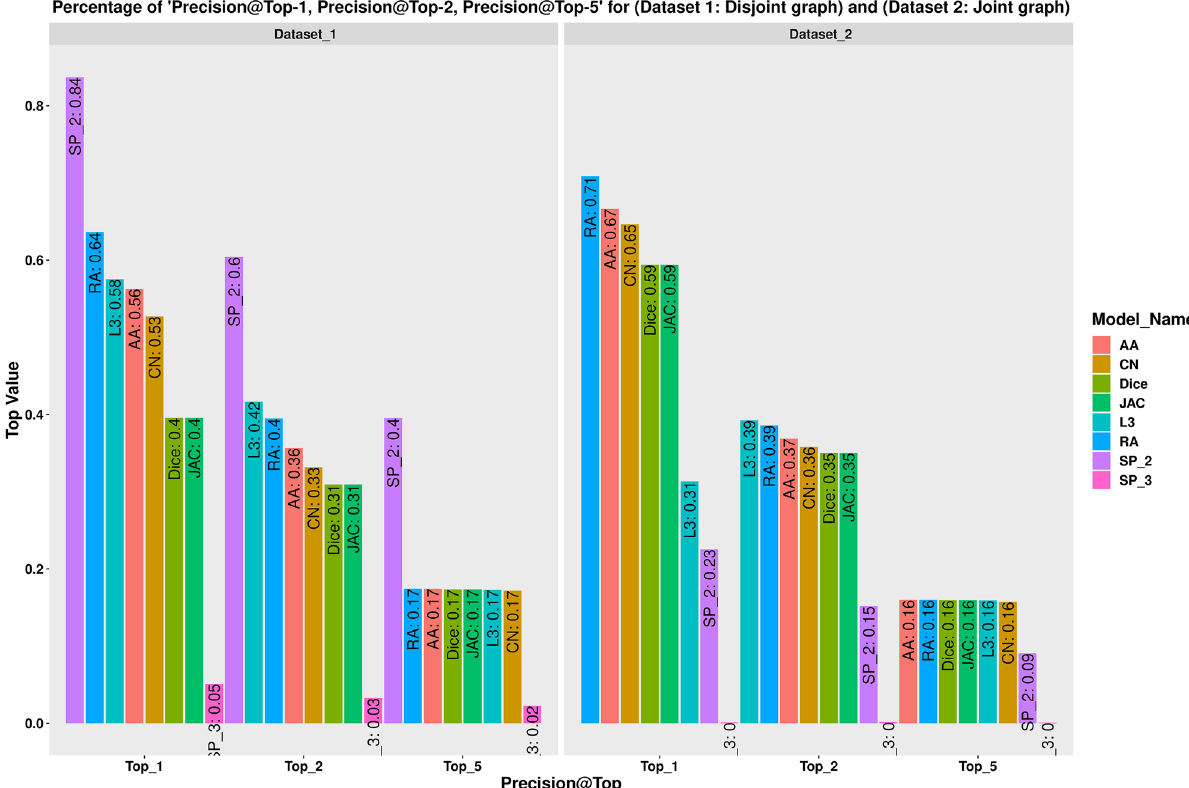
Figure 2. Comparison of the precision@top over eight methods and two different graph networks. This figure was generated using ggplot2 library from R v3.6.3.